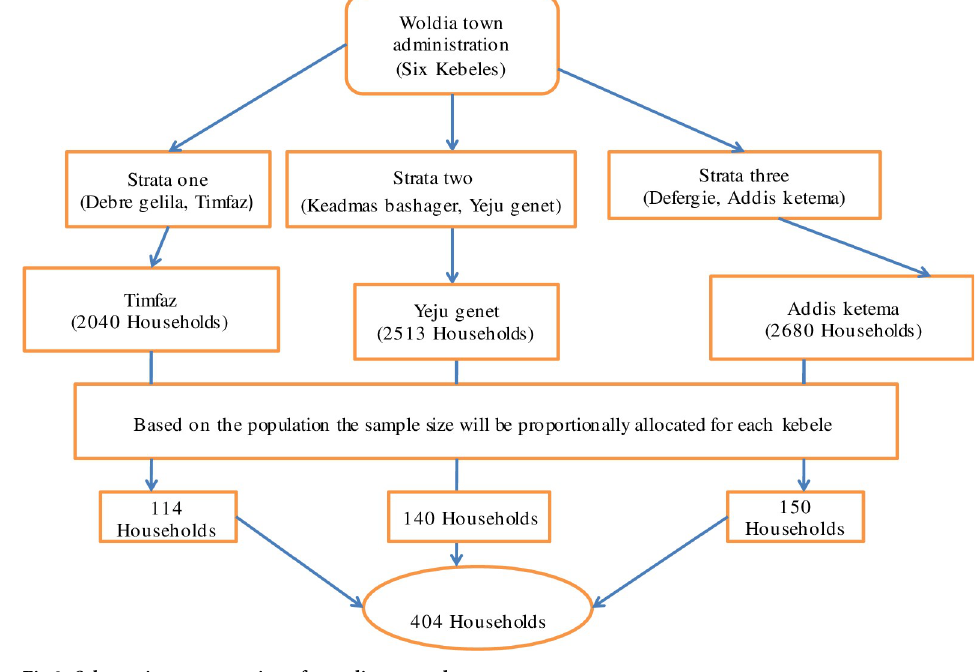
Fig 2. Schematic representation of sampling